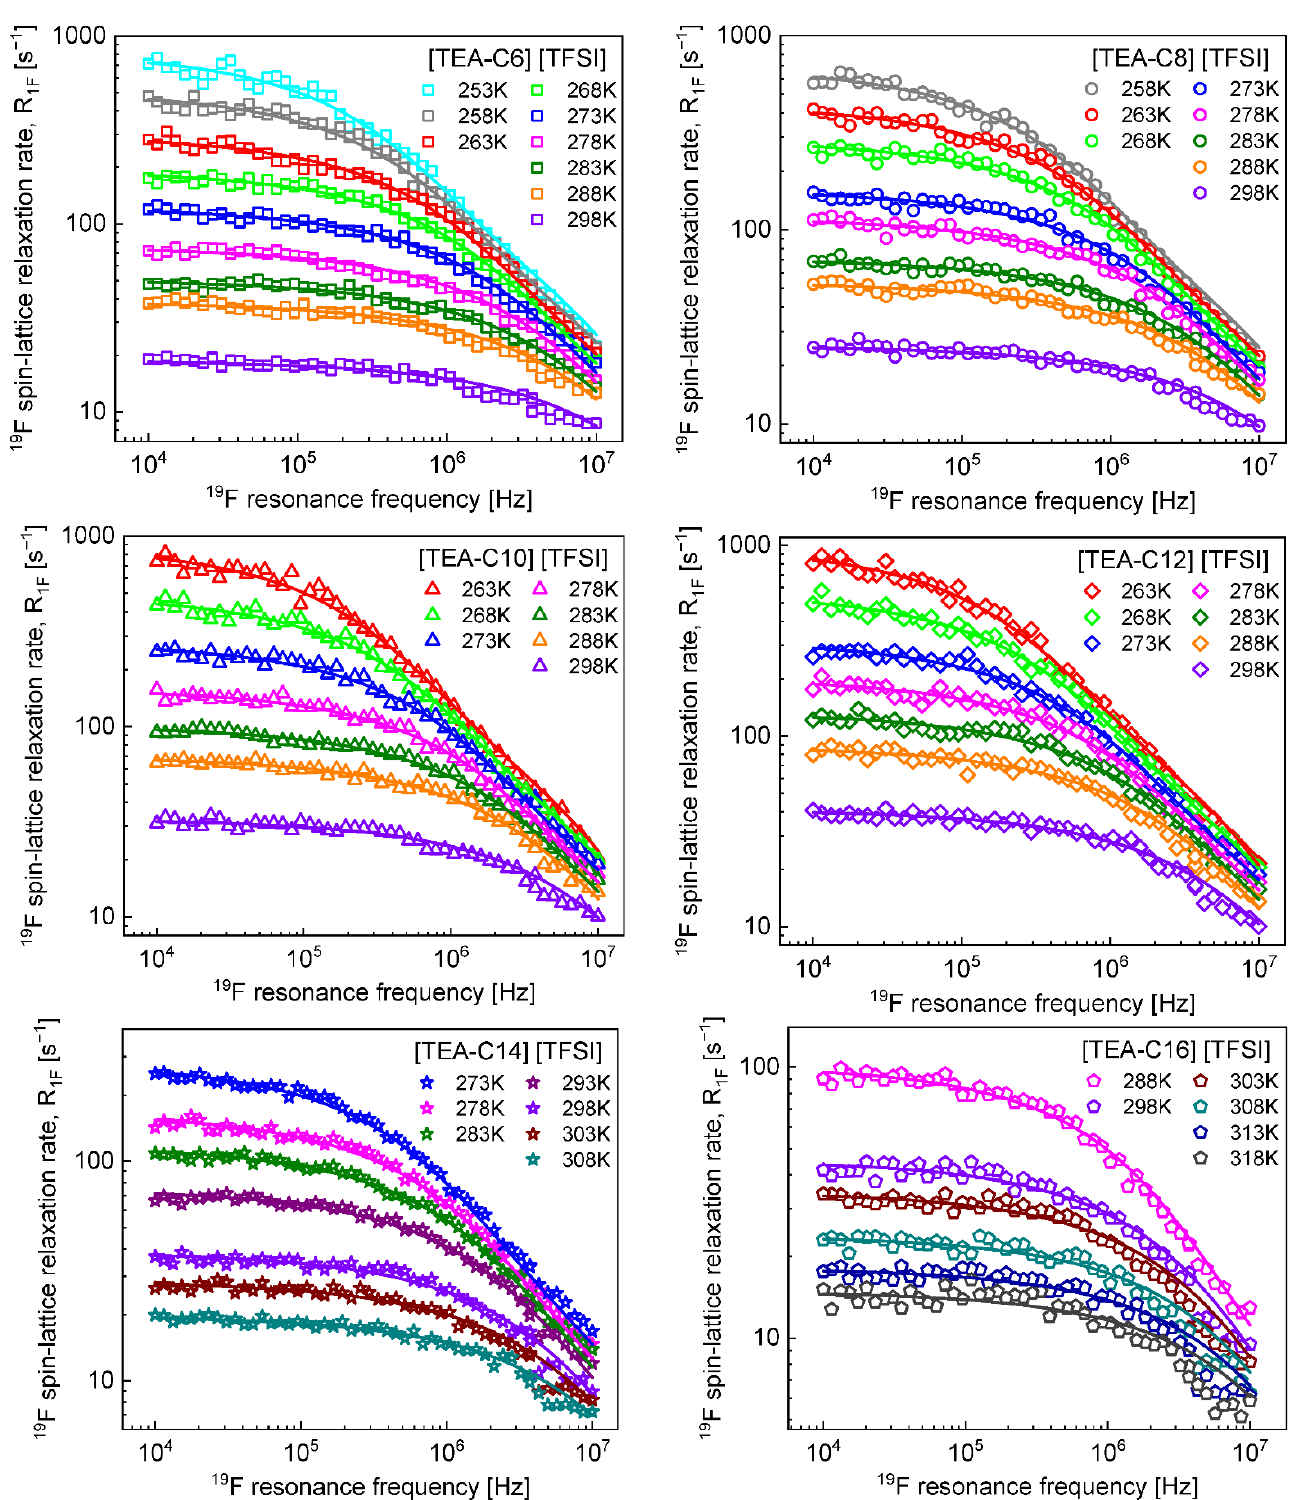
Figure 1. 19 F spin-lattice relaxation data for a series of ionic liquids: [TEA–C6] [TFSI], [TEA–C8] [TFSI], [TEA–C10] [TFSI], [TEA–C12] [TFSI], [TEA–C14] [TFSI], and [TEA–C16] [TFSI]. Solid lines—fits in terms of Equation (1).